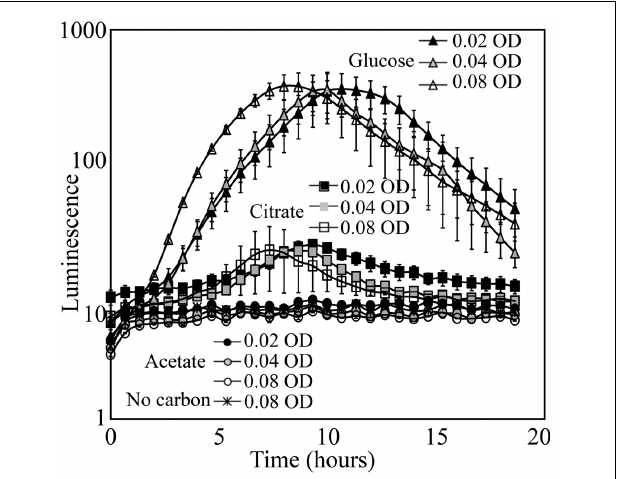
FIGURE 6 | Luminescence detected using a Retiga EX CCD camera from populations of the microbiosensor KT2440/pZKH2 established in soil in 96-well plates. Bacteria were grown in M9 with 0.4% (w/v) citrate, glucose, or acetate as carbon source, spun down and re-suspended to three optical densities for each source, then inoculated into soil. All values are mean ±